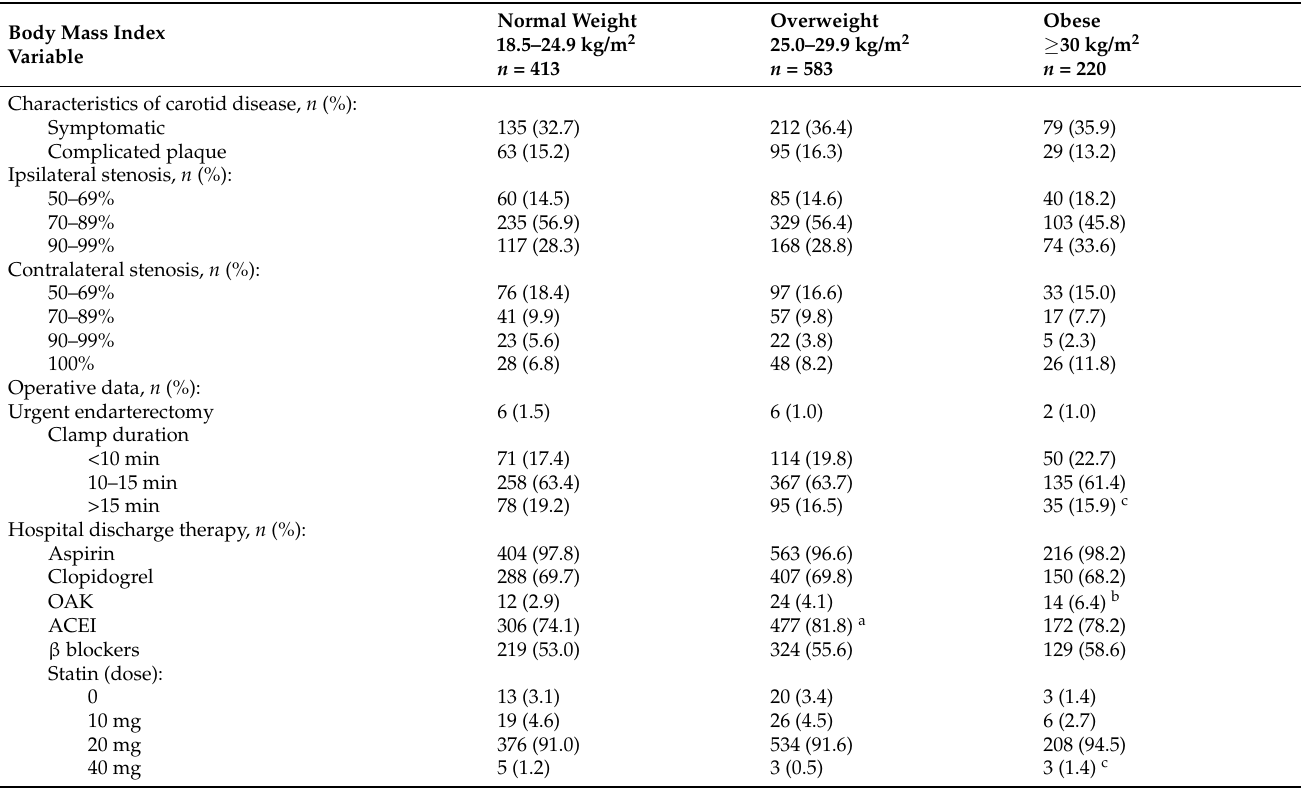
Table 2. Characteristics of carotid disease, operative data, and the hospital discharge therapy by body mass index, according to the univariate logistic regression analysis.